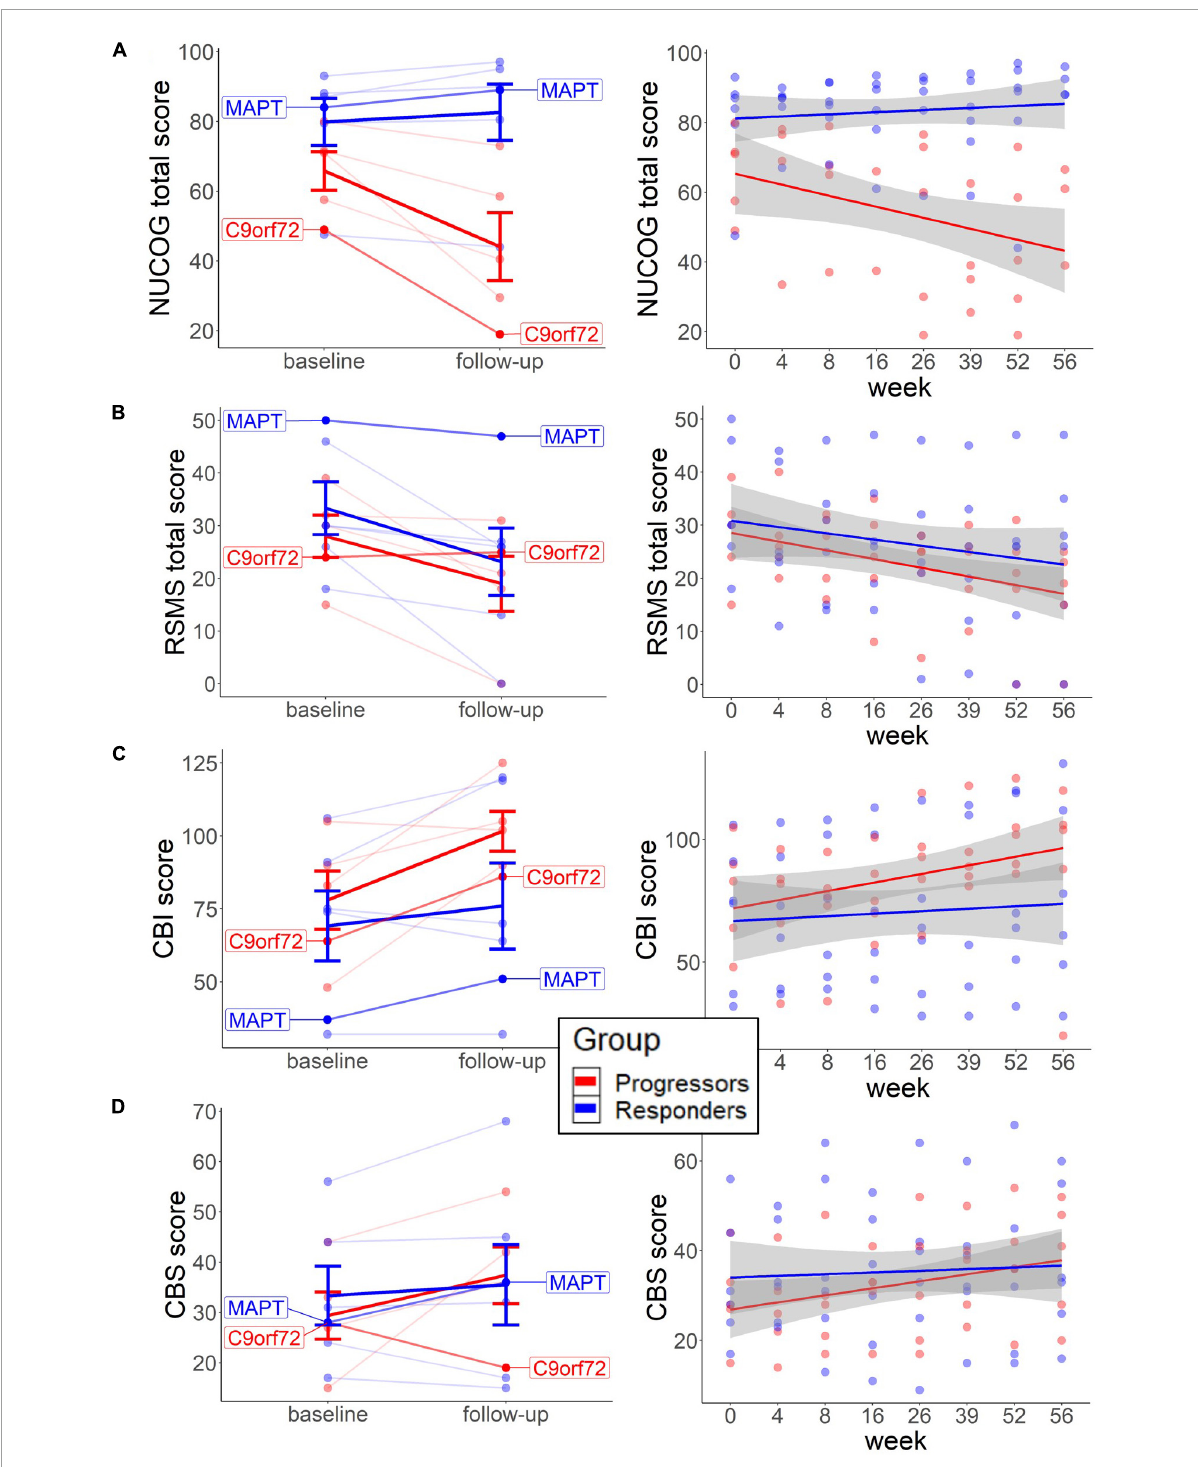
FIGURE1 Baseline scores and long-term neuropsychological change in each group. The left graphs represent the change from baseline to follow-up on the individual level for cognition (A) , social cognition (B) , behavior (C) , and carer burden (D) . Thick lines reflect group means. The right graphs (A–D) represent changes across multiple weeks from baseline to follow-up, with each line representing each group. Both patients with the identified mutation are highlighted. NUCOG, Neuropsychiatry Unit Cognitive Assessment Tool (total scores); RSMS, Revised Self-Monitoring Scale (total scores); CBI, Cambridge Behavioral Inventory; CBS, Caregiver Buden